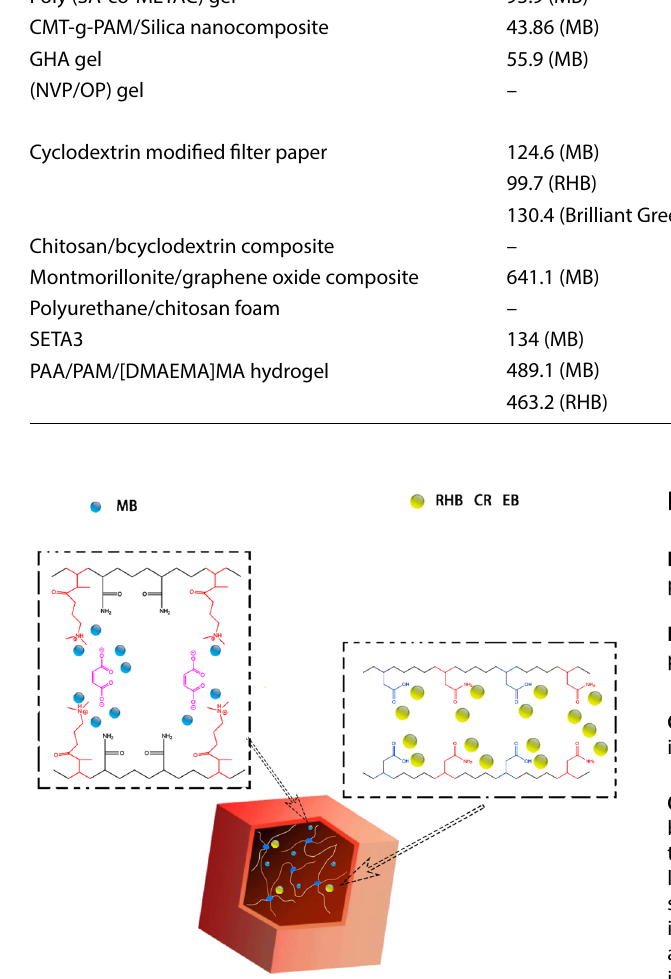
Fig. 11 Adsorption mechanism of different dyes on